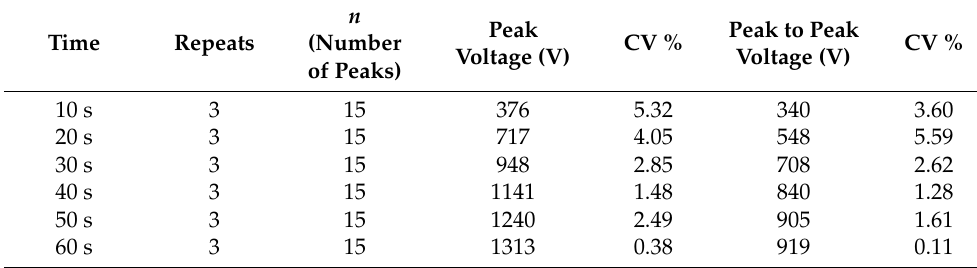
Table 3. The effect of the testing duration on the electrostatic charge